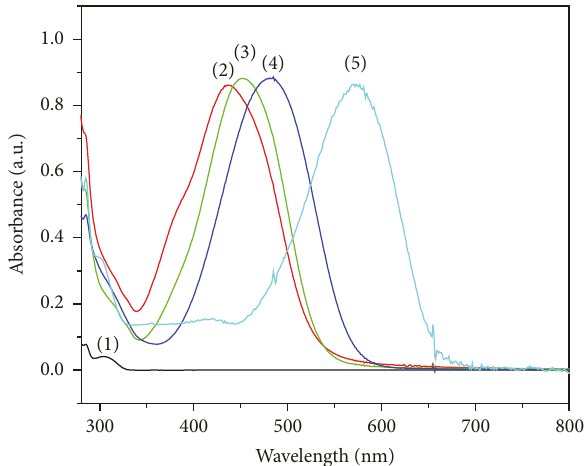
Figure 4: UV-vis spectra of the THF solution (0.02 mg/mL) of the polymers. Curve (1): PAZ, curve (2): PAZ-ET, curve (3): PAZ-CN, curve (4): PAZ-NT, and curve (5):